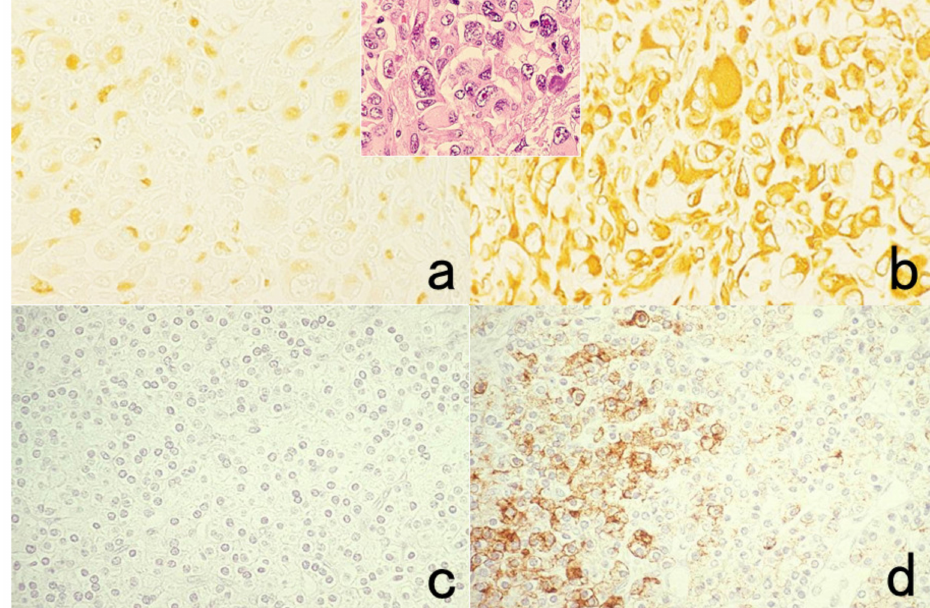
Figure 35. Application of HIER (II). Top panels ( a , b ): Vimentin in lung metastasis of anaplastic thyroid carcinoma (inset: H&E). Bottom panels ( c , d ): Parathyroid hormone in normal parathyroid gland. Left ( a , c ): Without HIER treatment and Right ( b , d ): after HIER with autoclaving at 121 ◦ C for 10 min in 10 mM citrate buffer, pH 6. Immunoreactivities of vimentin and parathyroid hormone are significantly retrieved by the hydrated heating